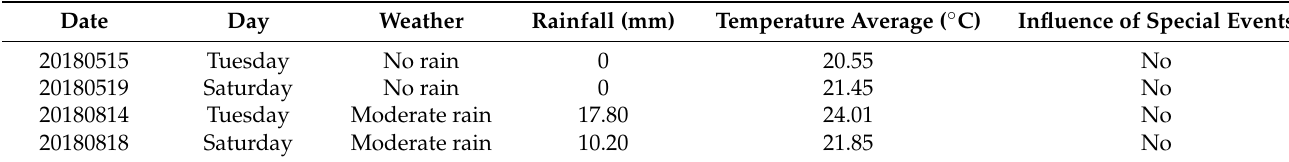
Table 2. Four-day basic